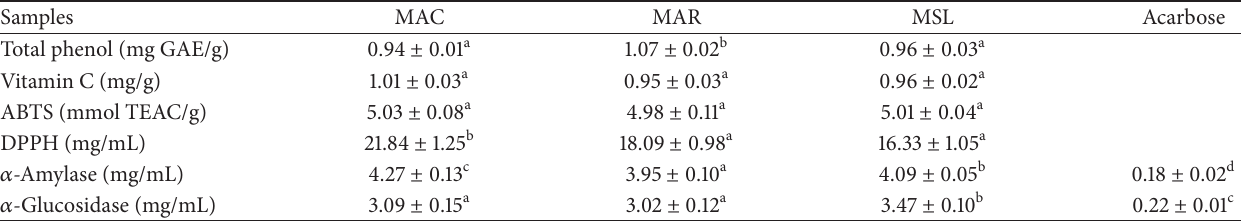
Table 2: Total phenol and flavonoid content and EC 50 values of DPPH radical scavenging ability and inhibition of 𝛼 -amylase and 𝛼 - glucosidase activities of Musa sapientum (Latundan banana) (MSL), Musa acuminata (Cavendish banana) (MAC), and Musa acuminate (Red Dacca)